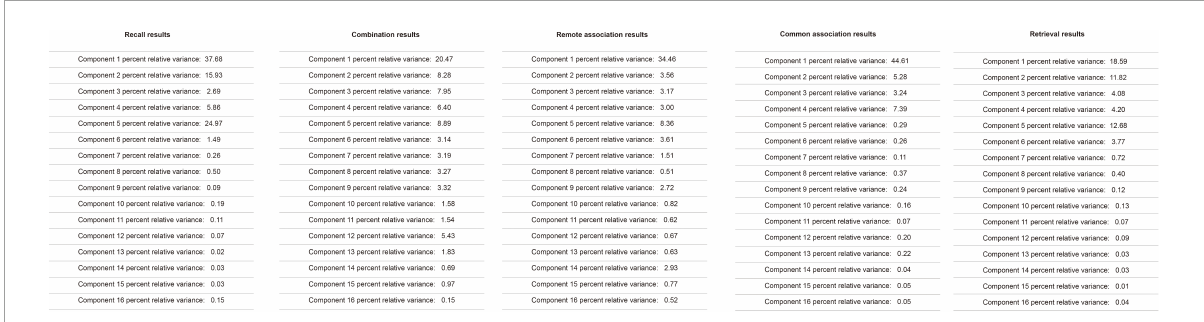
FIGURE3 Electroencephalography spectral analysis results for remote association, common association, recall, retrieval, and combination induction tasks.